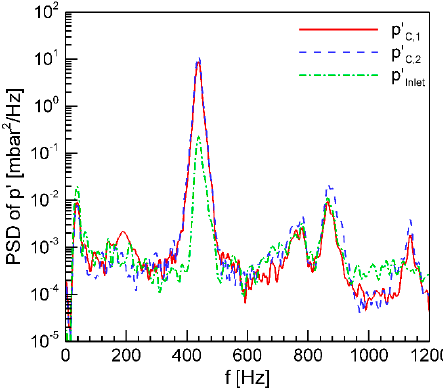
Figure 9. Power spectral densities of the filtered pressure fluctuations using C 2 H 4 at L C = 895 mm, SN = 1.40, u = 10 m/s, and φ =